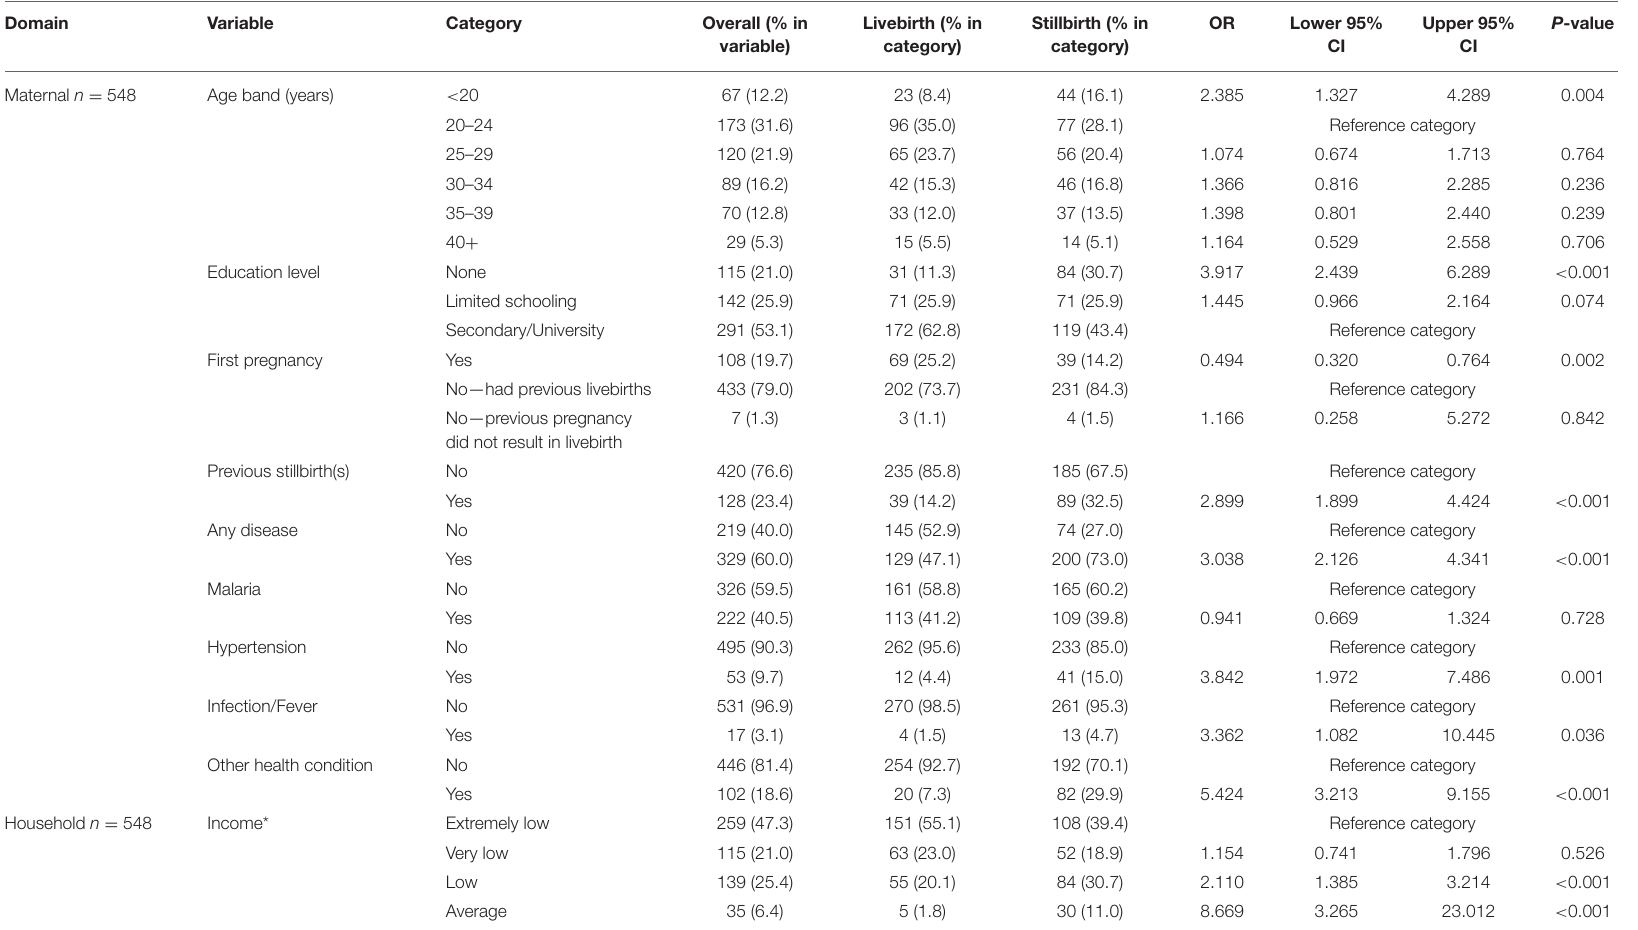
TABLE 1 | Univariable results from S1: Case-control study detailing demographic characteristics, the distribution of variables within each of the domains, and the extent to which each variable is associated with stillbirth.